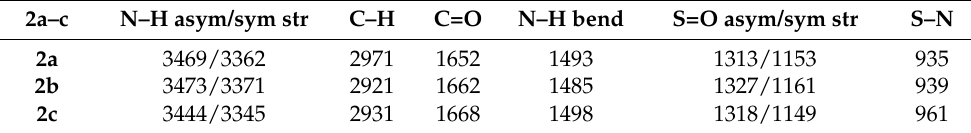
Table 1. The experimental IR frequencies (cm − 1 ) for compounds 2a – c